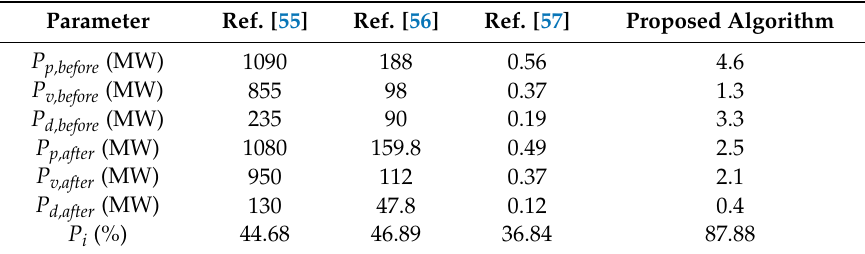
Table 2. Comparative analysis of the proposed algorithm with other approaches for grid load variance